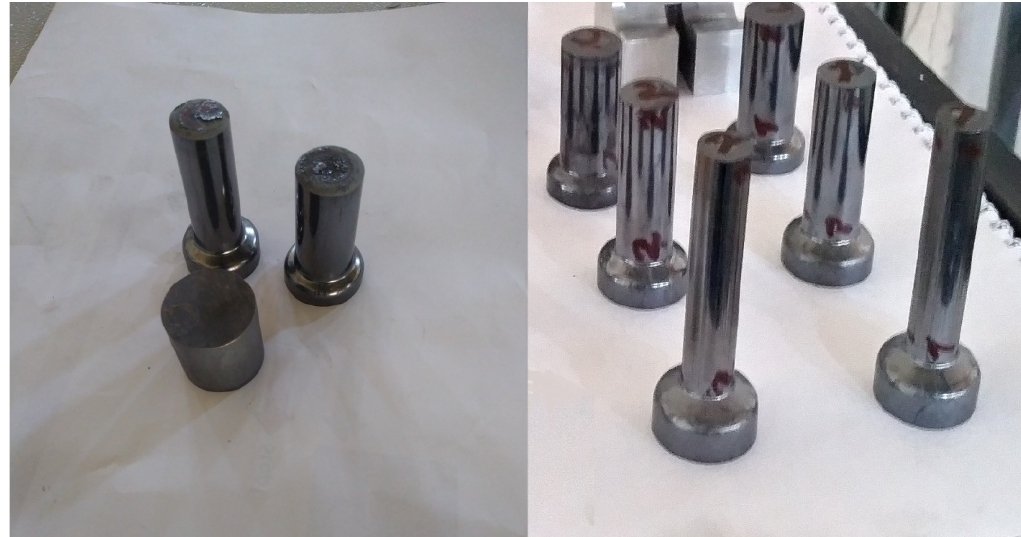
Figure 1. (a) an initial material and cold extruded specimens (b) the cold extruded specimens at three true